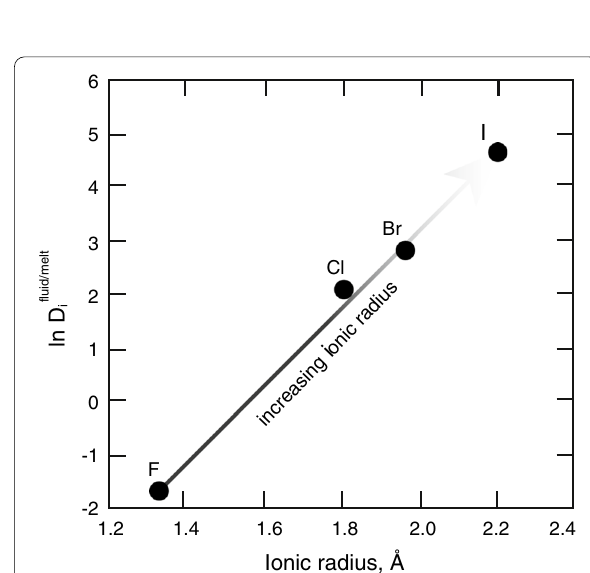
Fig. 8 Fluid/melt partitioning at 200 MPa and 900° as a function of the ionic radius of the halogen. (The melt composition is (wt%): SiO 2 : 67.09, Al 2 O 3 : 18.08, Na 2 O: 11.06.) (Modified after Bureau et al. 2000